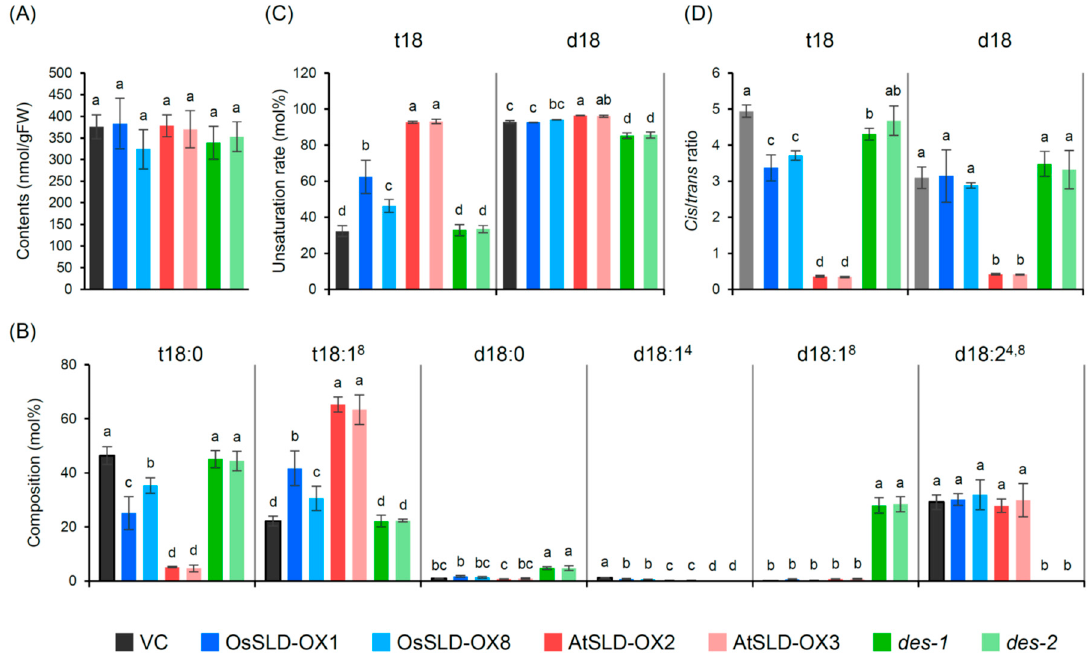
Figure 3. LCB profiling of the transgenic rice plants. LCBs were liberated from root tissues by direct strong alkaline hydrolysis and analyzed by LC-MS/MS. ( A ) Total LCB contents. ( B ) Composition of LCB species. ( C ) Unsaturation rate (mol% of Δ 8 unsaturated species each of t18 and d18 LCB). ( D ) Cis / trans ratio of Δ 8 unsaturation. Data are means ± SDs ( n = 4). Different letters indicate statistical significance (Tukey’s HSD, P < 0.05).